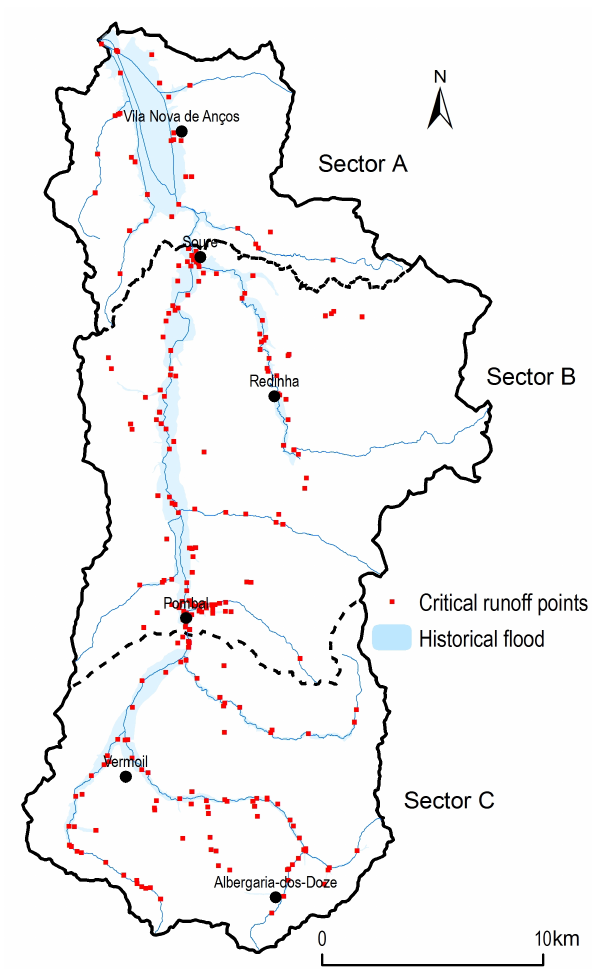
Fig. 7. Flood-prone areas and critical runoff points (CRPs).